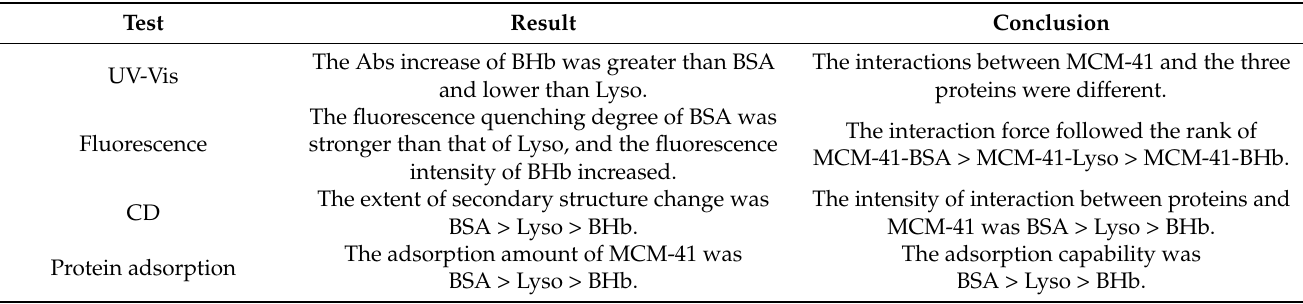
Table 1. The results of the study on MCM-41-proteins.